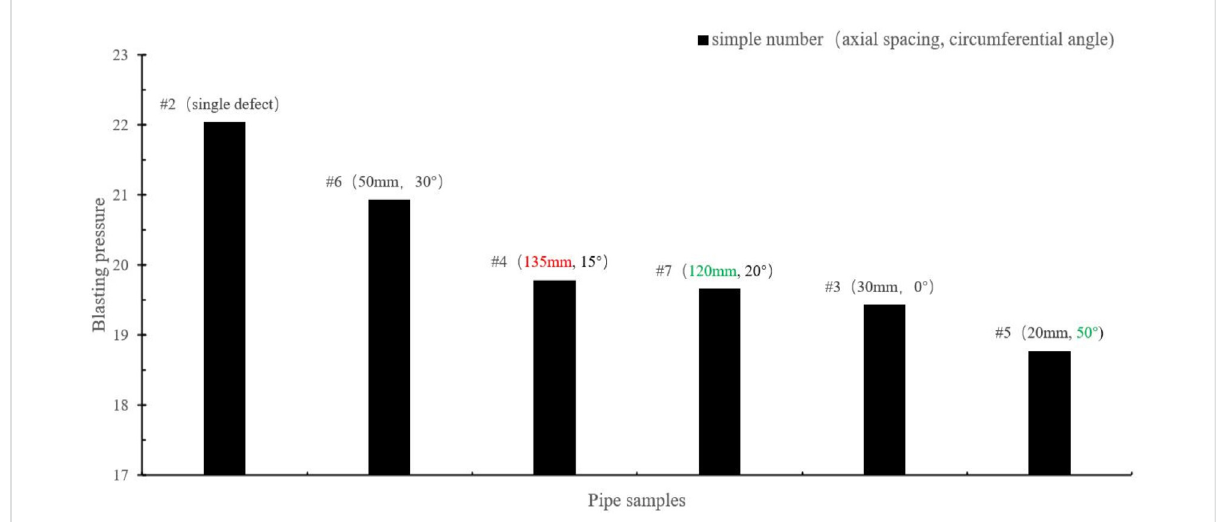
FIGURE 12 Pipeline sample arrangement (according to burst pressure values).